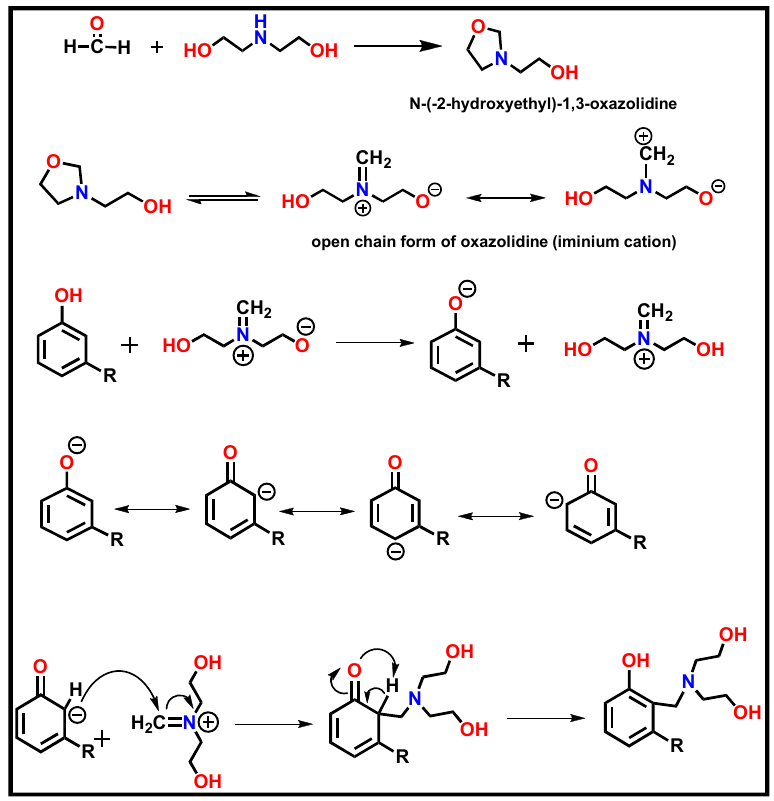
Figure 1. Mechanism for the formation of cardanol Mannich polyol. Structural confirmation of the cardanol-based polyol was performed by FT-IR and 1 H NMR spectroscopies. The FT-IR spectrum of CMP is represented in Figure 2 and the corresponding functional groups are tabulated in Table 2. Table 2. Peaks observed in FT-IR spectra of cardanol and cardanol Mannich polyol and magnetic hydroxyapatite nanoparticles and the corresponding functional groups.